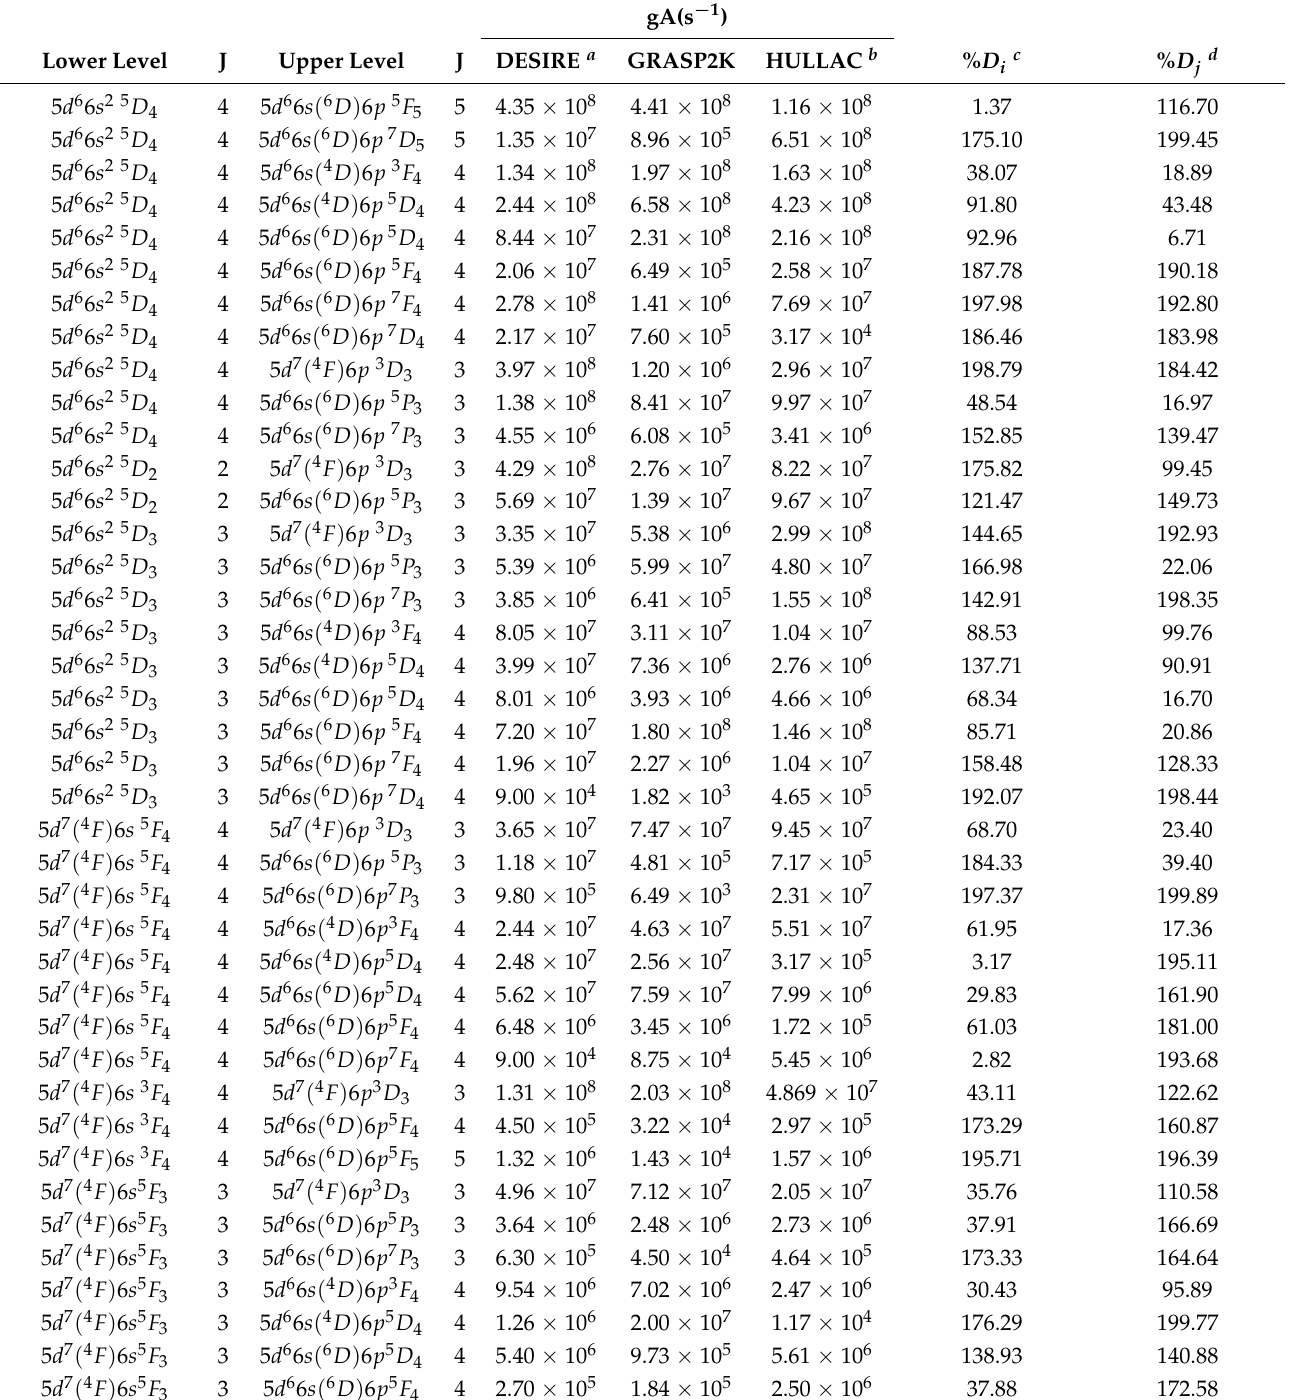
Table 6. Weighed transition probabilities (gA-values) for Os